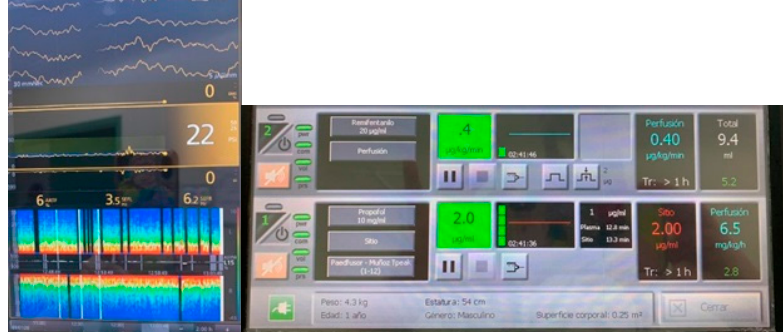
Figure 4. A 6-weeks old child, 4.3kg, biliary atresia, General anesthesia with Propofol TCI, Remifentanil manual calculation. The raw EEG and the spectrogram show an important depression of the SEF95, many Burst suppression episodes and asymmetry between both hemispheres, no alpha activity using extremely low Propofol concentration.